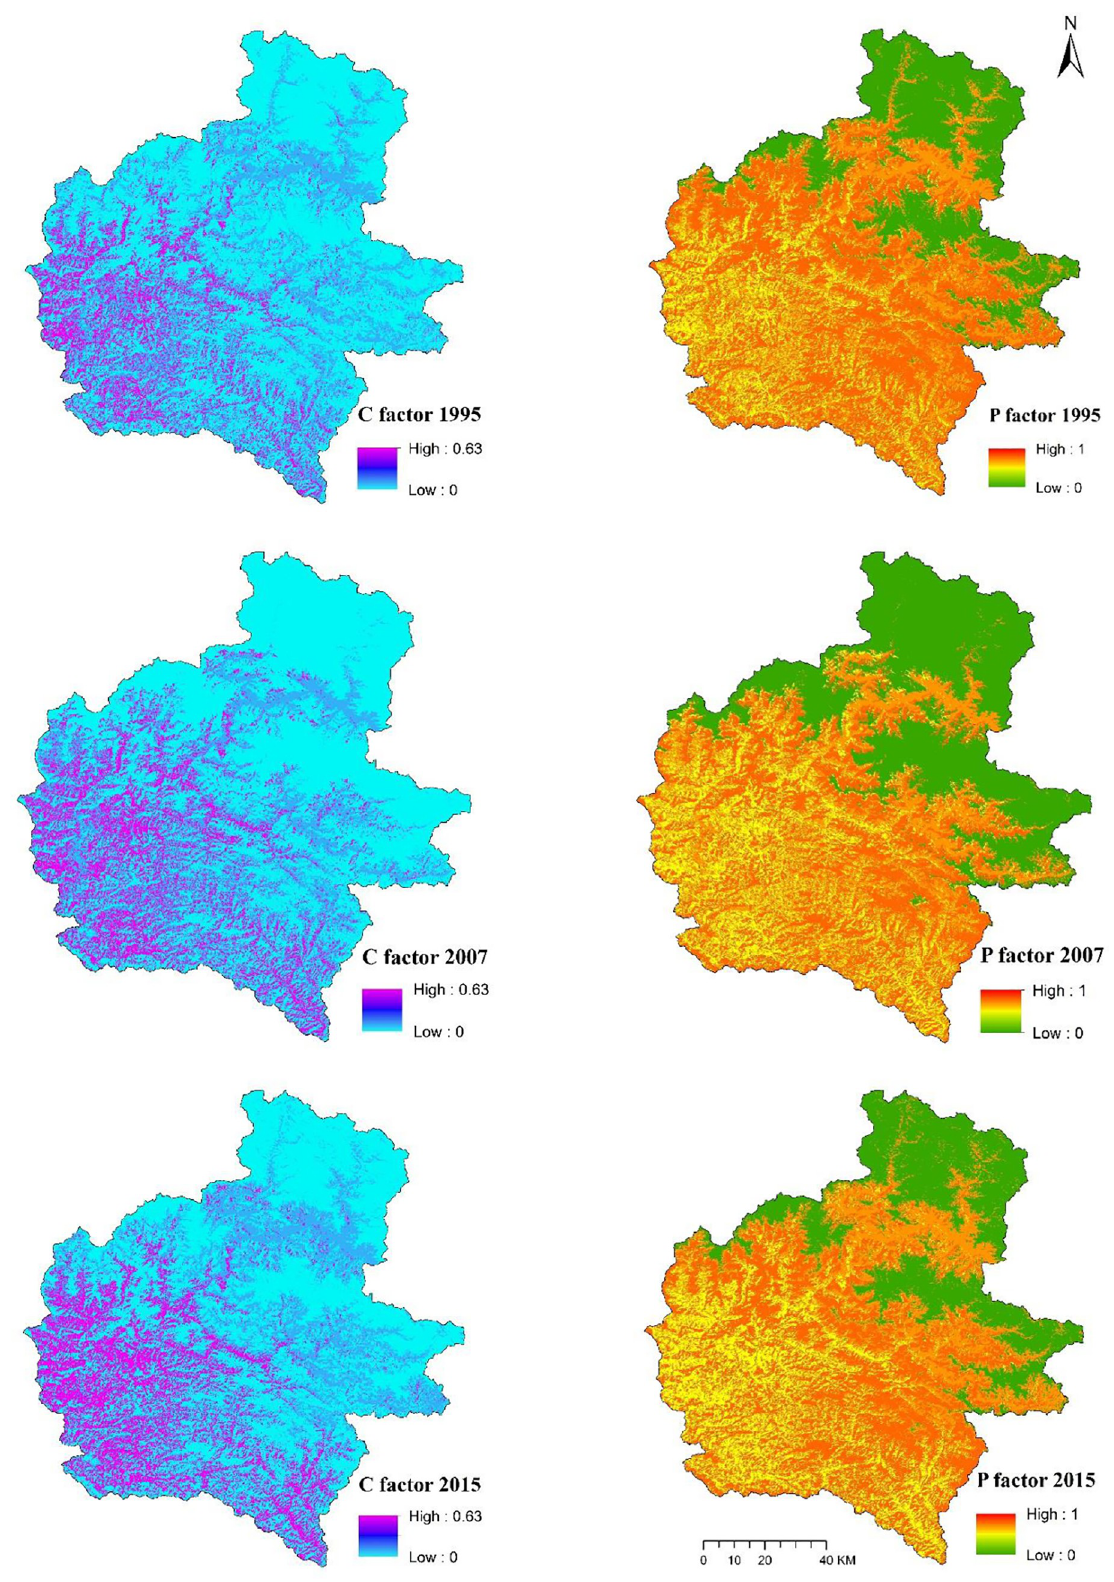
Fig 7. Spatial distribution of C and P factors for 1995, 2007 and 2015. https://doi.org/10.1371/journal.pone.0231692.g007 PLOS ONE | https://doi.org/10.1371/journal.pone.0231692 April 15,